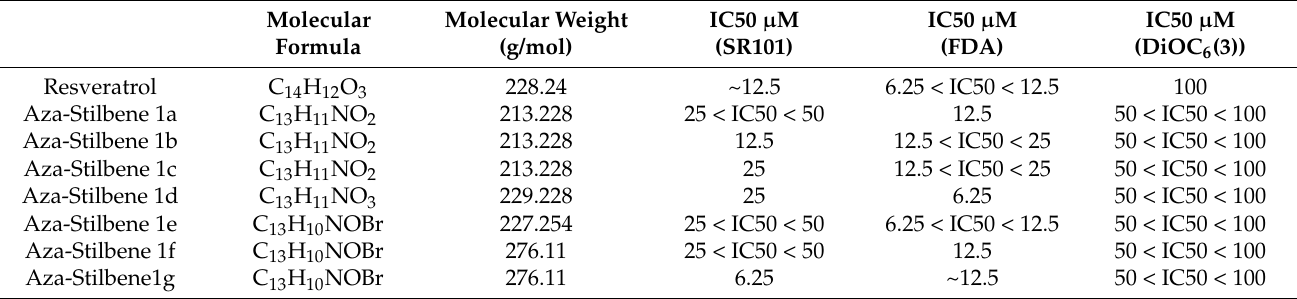
Table 1. IC50 values of resveratrol and aza-stilbenes 1a to 1g obtained with the SR101, FDA et DiOC 6 (3) assays. Sulforhodamine 101 (SR101, evaluation of cell density), fluorescein diacetate (FDA, esterase activity/evaluation of cell viability) and DiOC 6 (3) (measurement of transmembrane mitochondrial potential ( ∆Ψ m)). Aza-stilbenes were compared with resveratrol ( trans-